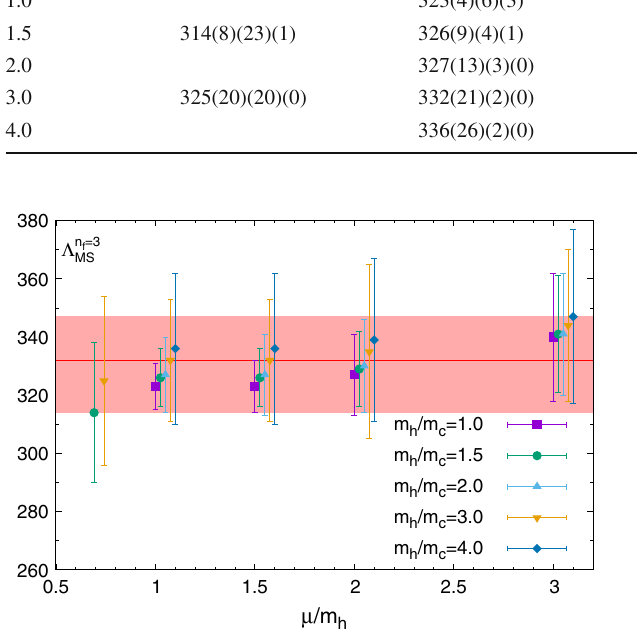
Fig. 4 The three-flavor Lambda parameter determined for different μ/ m h . The different symbols correspond to different values of m h and have been slightly shifted horizontally for better visibility. The hori- zontal line corresponds to the final estimate of Λ n f indicates its uncertainty perturbative error and the error due to scheme choice added in quadrature, since these errors can be assumed to be uncor- related for different m h and μ . This results in Λ